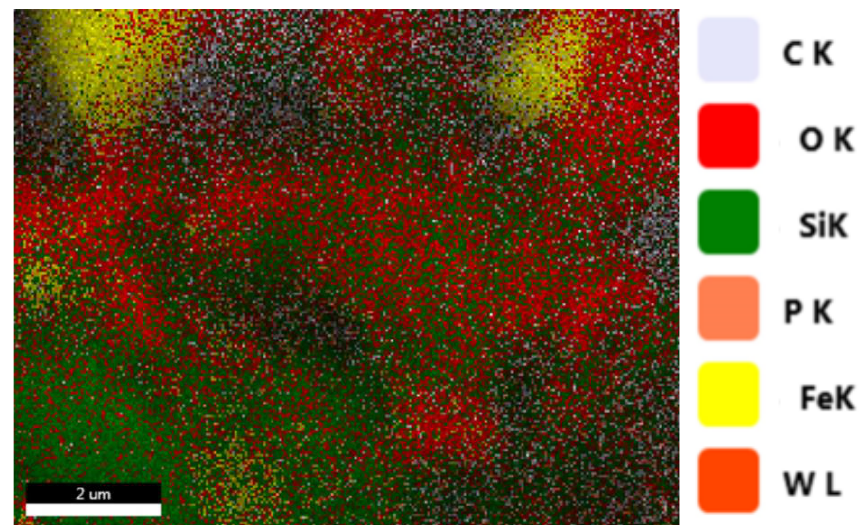
Figure 2. EDS element overlay map of the Fe 3 O 4 @SiO 2 @HPW catalyst.